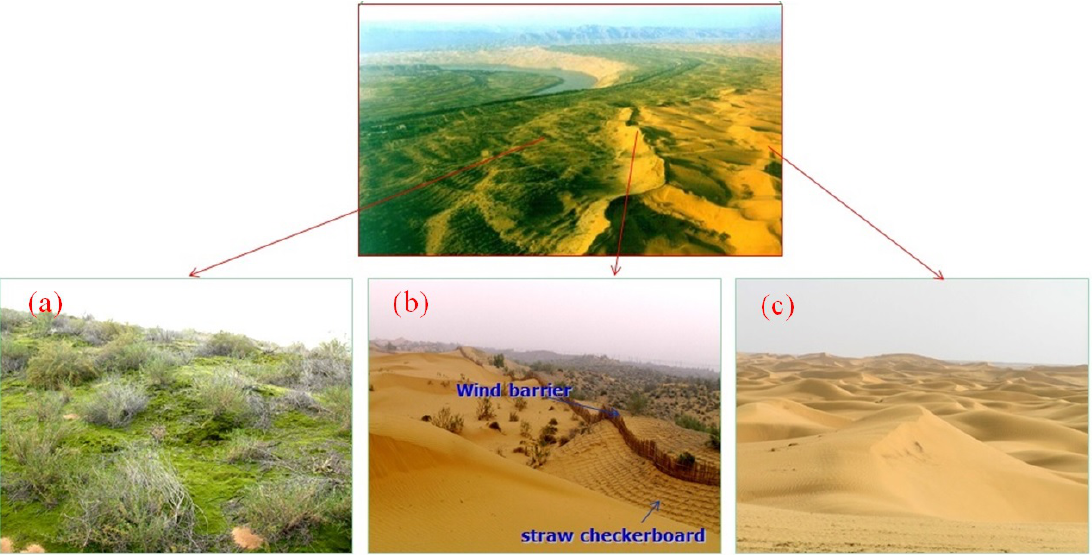
Figure 1. Main landscapes of the Shapotou region at the southeastern edge of the Tengger Desert. As a pioneer species, Bryum argenteum Hedw. has colonized and flourishes on the soil surface of the revegetation area (a) ; this was achieved by controlling burial stress through the combined application of wind barriers and straw checkerboards and the planting of shrubs without irrigation (b) ; 60 years ago, the area was characterized by shifting sand dunes (c)